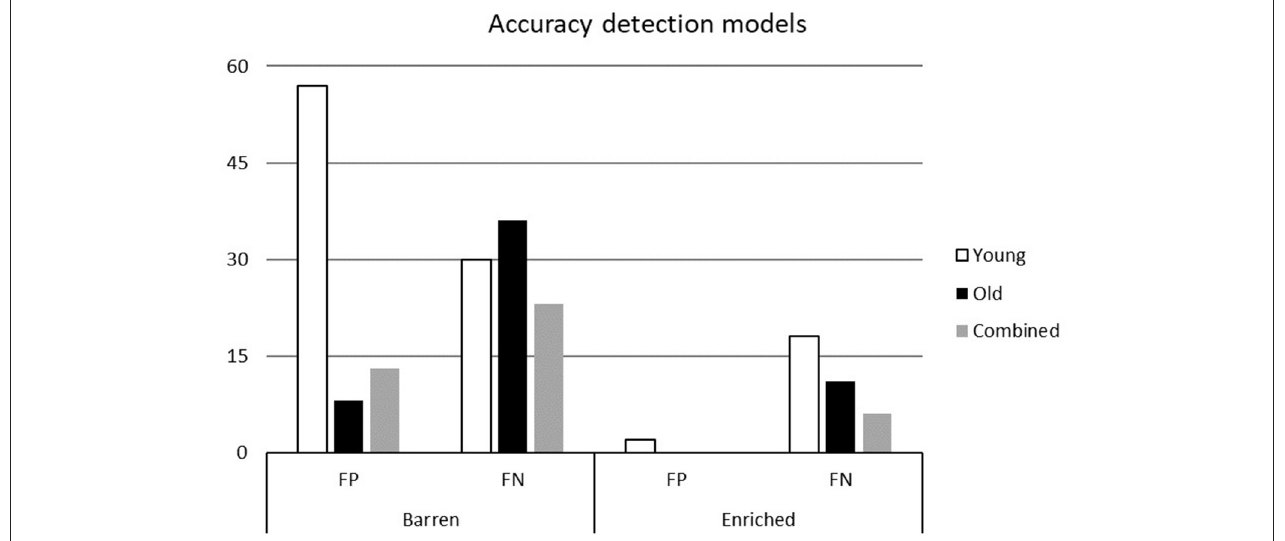
FIGURE 5 | The number of false positives (FP; i.e., tracks not associated with a pig) and false negatives (FN; i.e., undetected pig) for the barren and enriched environment using the “young,” “old,” and “combined” detection model.